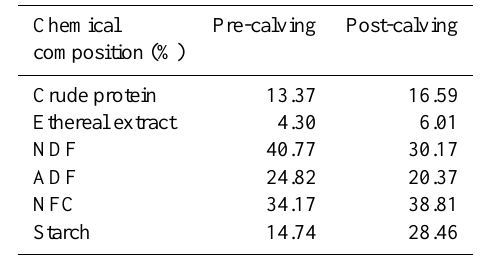
Table 1. Analytical composition of diets administered during pre- calving (Pre/C) and post-calving (Post/C)